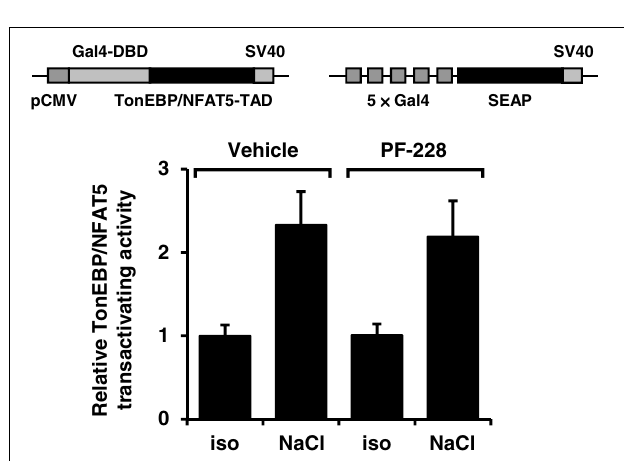
FIGURE 7 | Effect of FAK inhibition on TonEBP/NFAT5 transactivating activity. HEK293 cells were electroporated with pGAL4-TonEBP-TAD and pFR-SEAP as described in Methods. Subsequently, the cells were incubated for 24h in isotonic (300mosm/kg H 2 O) or hypertonic medium (450mosm/kg H 2 O by NaCl addition) in the presence or absence of 10 μ M PF-228 or only vehicle ethanol. Thereafter, reporter activity was determined as described in Methods. Means ± s.e.m. for n =